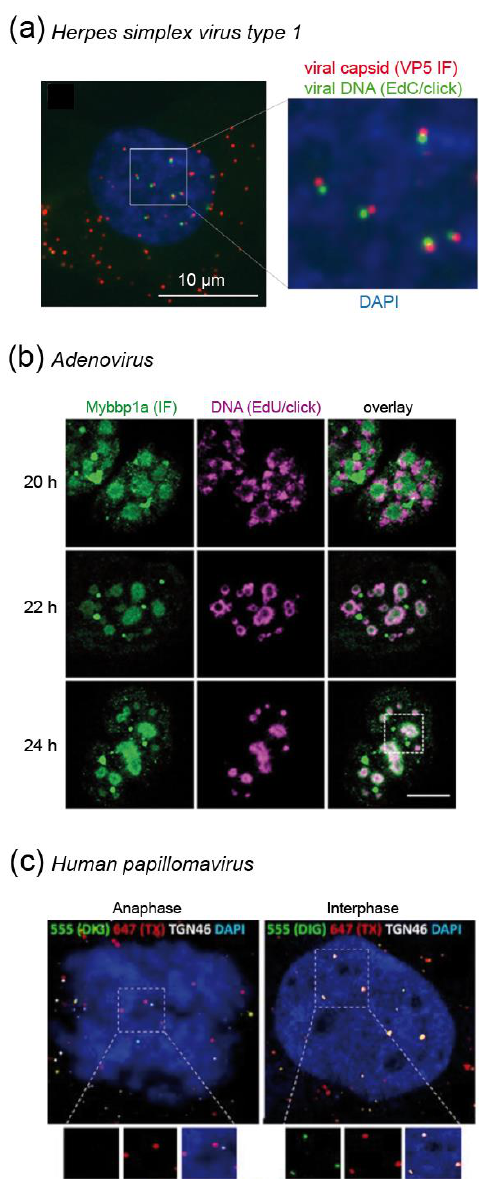
Figure 6. Examples for visualization of DNA virus replication stages. ( a ) Quantitative detection of HSV-1 uncoating. The maximum projection shows accessible viral genomes in the nucleus (green) still closely associated to viral capsids (red). Viral DNA contained in capsids in the cytosolic area is not accessible to the fluorophore (red signals only) [72]. ( b ) Pulse-chase labeling of nascent AdV DNA in the nucleus of virus producing cells shows relocalization of labeled DNA from the periphery to the core of viral replication centers from 20 – 24 h post infection [73]. ( c ) Differential accessibility of HPV DNA to fluorophores after mild (green) and harsh (red) detergent treatment of infected cells reveals that the incoming viral genome is protected in vesicles during anaphase (left panel; red signals only) and becomes accessible upon completion of mitosis (right panel; co-localization of green and red signals) [74]. Images were modified from the indicated references, with permission.